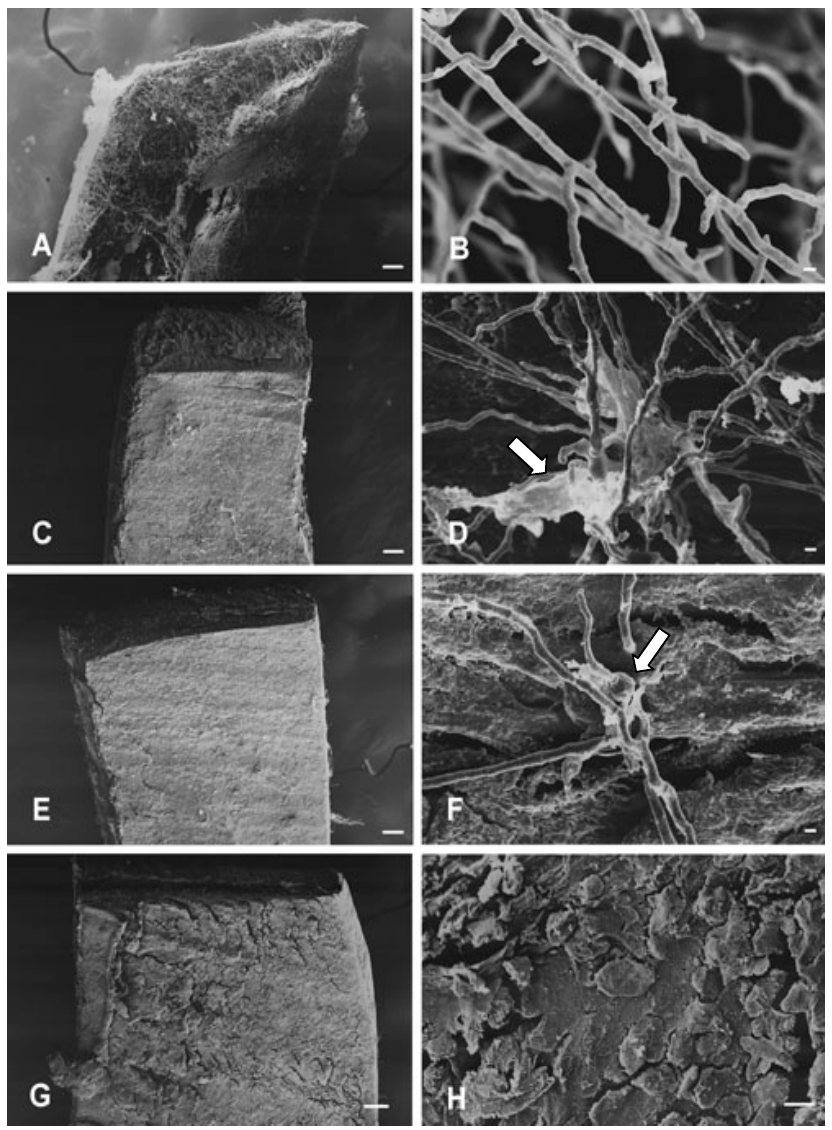
Figure 1 . Scanning-electron microscopy showing mycelial structures of T. mentagrophytes cultured on nail fragments for 72 h, at 28 º C: (A-B) Control, (C-D) Treatment with TIO C 55  mol L -1 . (E-F) Treatment with TIO C 110  mol L -1 . (G-H) Treatment with TIO C 220  mol L -1 . View of nail fragment in (A) colonised by T. mentagrophytes. (C) and (E) show the inhibitory effect of TIO C on the invasion of nails. In (D) and (F) arrows indicate excretion of fibrillar materials and swollen structure. Figures (G) and (H) show that no mycelial growth can be seen on nail scales. Bars: 100  m (A,C,E,G); 10  m (H); 1  m